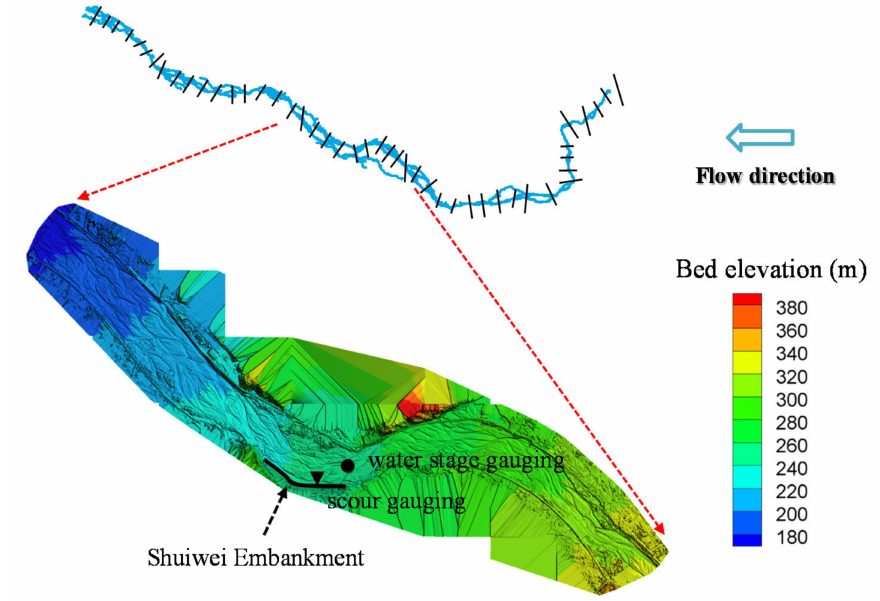
Figure 4. Model setup for WASH1D and SFM2D